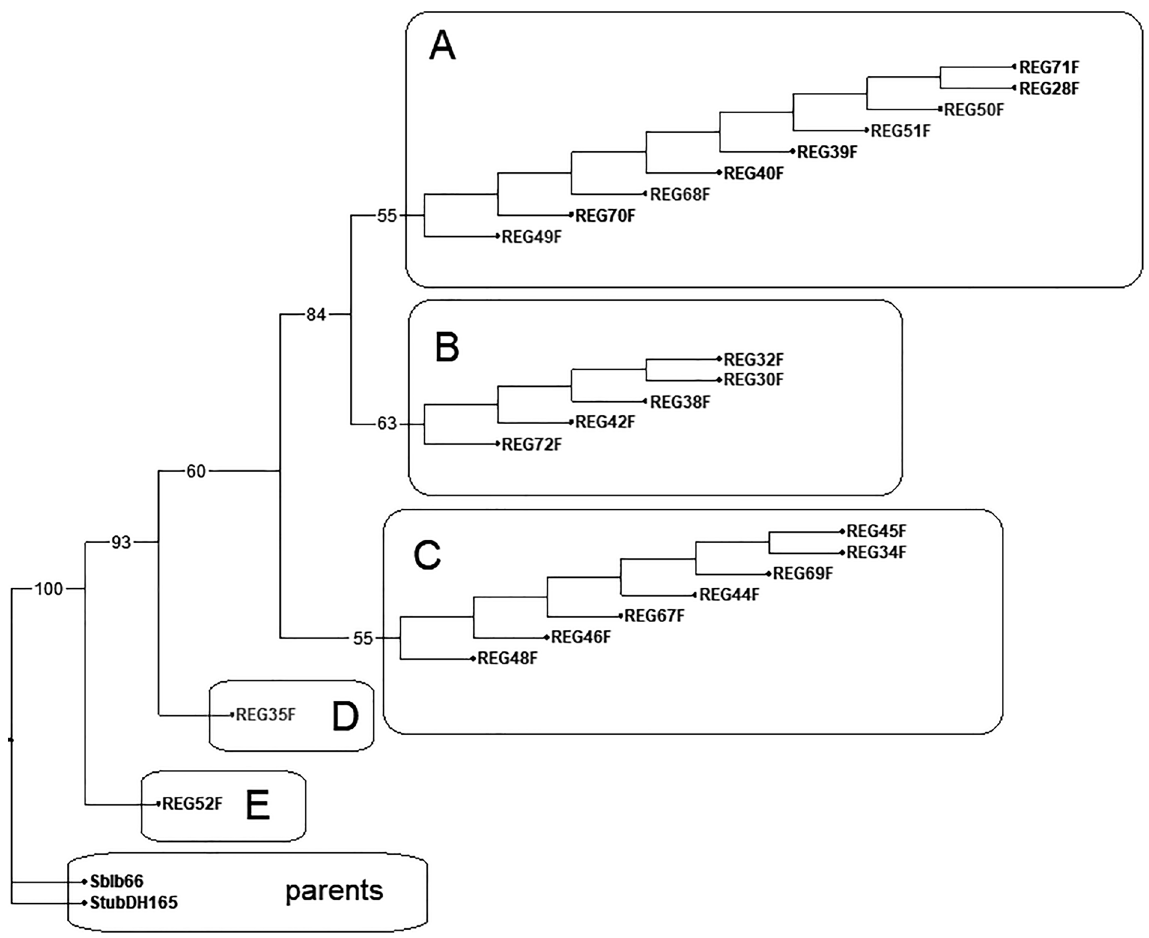
Figure 1. Genetic distances in the ncSSR of somatic hybrids indicates somaclonal variation dividing the somatic hybrids into five distanced groups. Designed in Darwin 6 software 35 , processed in Zoner Photo Studio 14. Stub DH alleles Sblb alleles Combined alleles New alleles Null